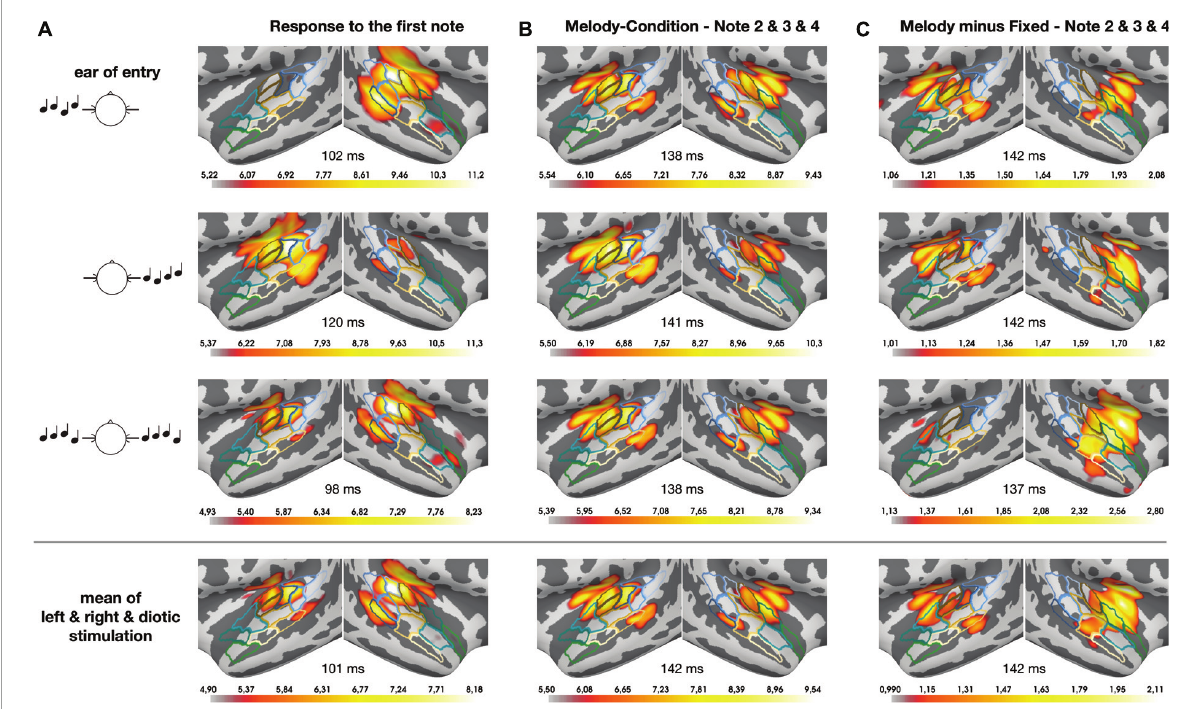
FIGURE3 Temporal lobe MNE representation (dSPM) of the neural responses in the monaural left and right (top and 2nd panels) and the diotic (3rd panels) listening conditions, separately for the first note (A) and for the pooled second, third, and fourth note (B) of the (melodic) sequences, as well as for the pooled within-sequence activity based on the contrast between sequences with fixed vs. varying pitch (C) . The bottom panels depict the mean values across the entry-of-ear conditions to illustrate the anterior-posterior shift from panels (A) to (C) in both hemispheres. All representations cover the time interval of the corresponding N100m waves; small numbers shown between hemispheres indicate the corresponding N100m peak times. Color linings indicate the ROIs in PT (blue) and PP (green), as well as intermediary areas (beige; cf. Figure 2 ). The color code of the activation results from auto-rescaling within the MNE software, separately for each subplot (minimum: 96th percentile, maximum: 99.5th